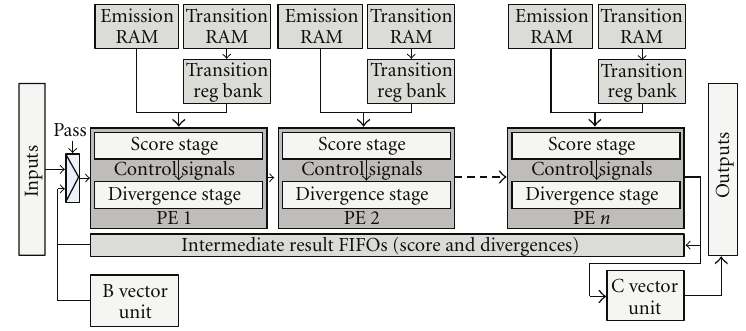
Figure 7: Block diagram of the accelerator